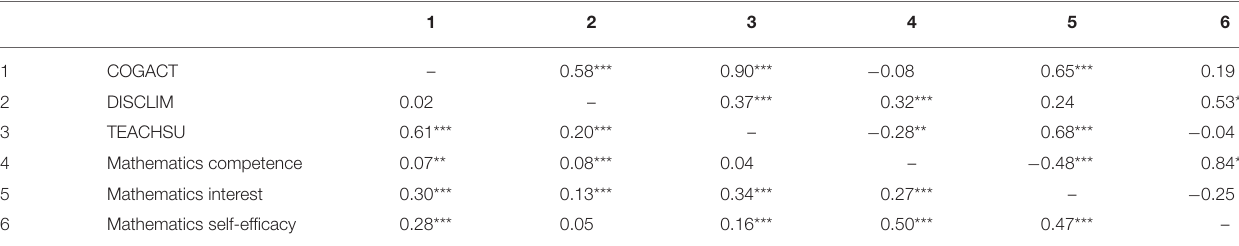
TABLE 2 | Intercorrelations at the class level (above the diagonal) and at the individual level (below the diagonal) for the lower school